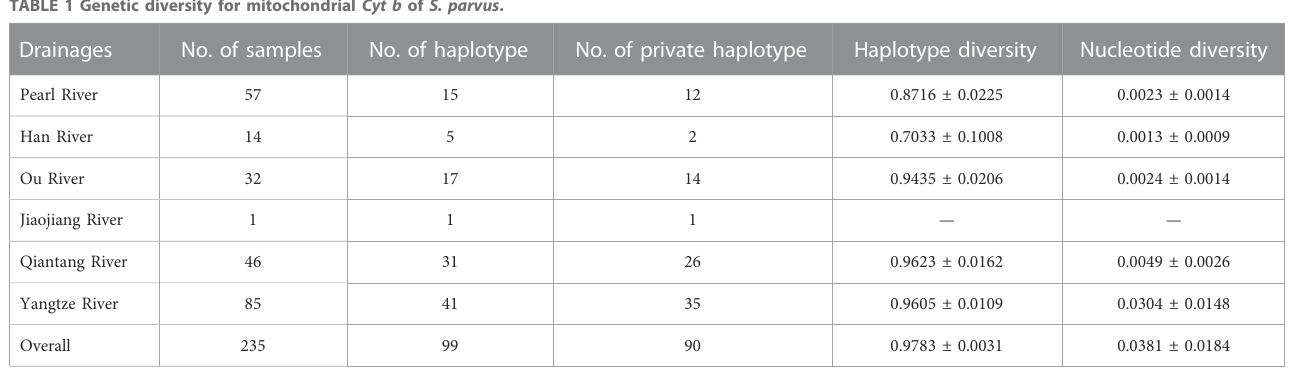
TABLE 1 Genetic diversity for mitochondrial Cyt b of S. parvus